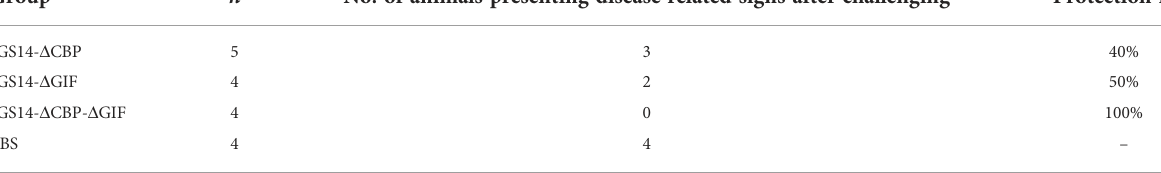
TABLE 2 Protective ef fi cacy of gene deleted recombinant viruses. Group n No. of animals presenting disease related signs after challenging Protection rate